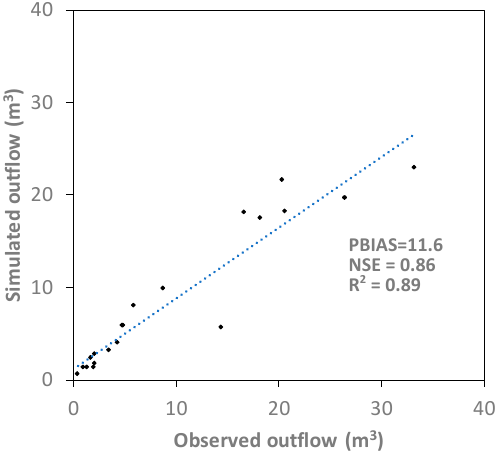
Figure 17. Comparison of simulated outflow versus observed outflow.